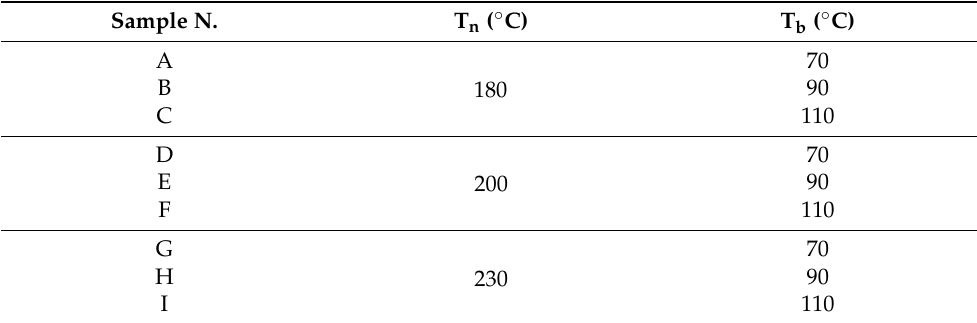
Table 1. Nozzle and printing bed temperatures (T n and T b , respectively) were adopted during fused filament deposition (FDM) of polylactic acid (PLA).